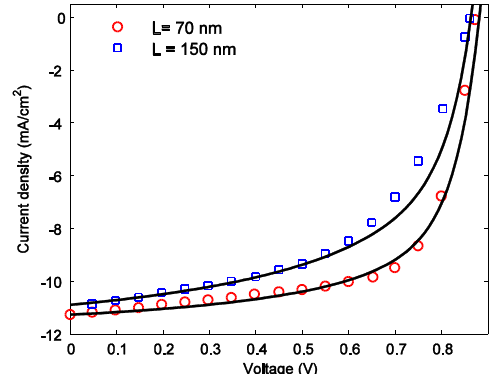
Figure 6. Current-voltage characteristics of PCDTBT solar cells for different active layer thicknesses. The symbols and solid lines represent experimental data and model fit to the experimental data, respectively.